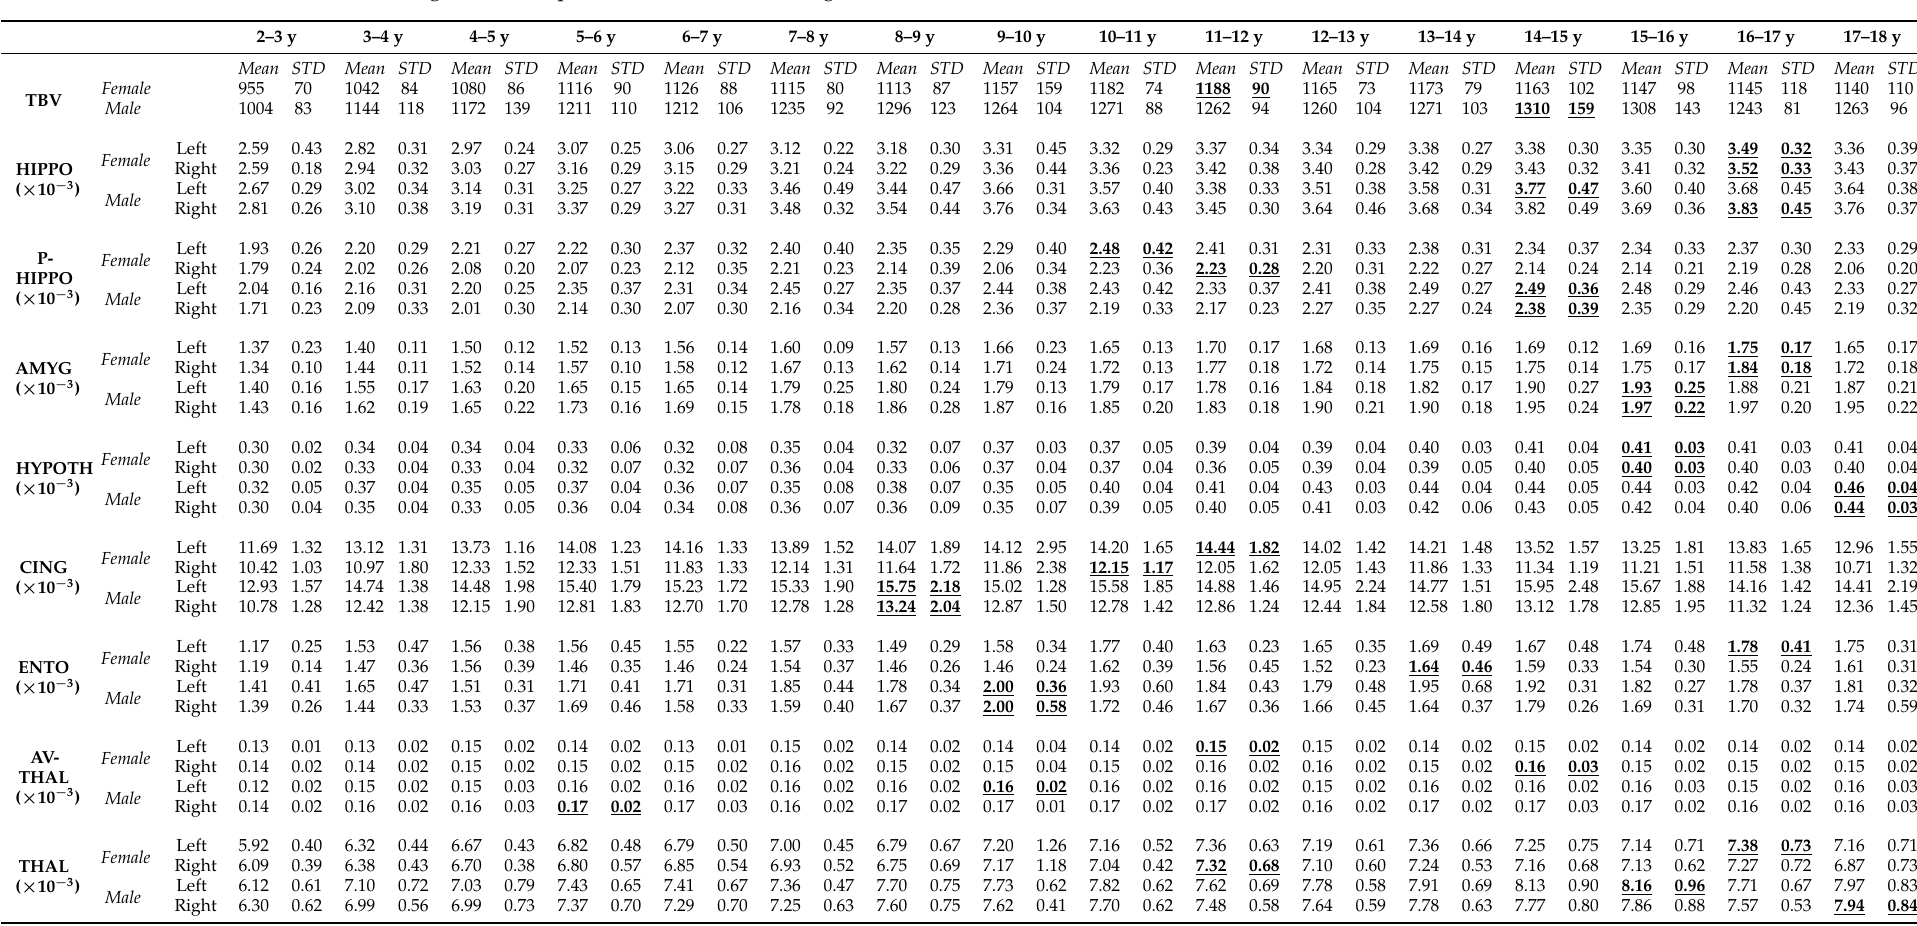
Table 2. Age- and sex-specific mean volumes of regions of